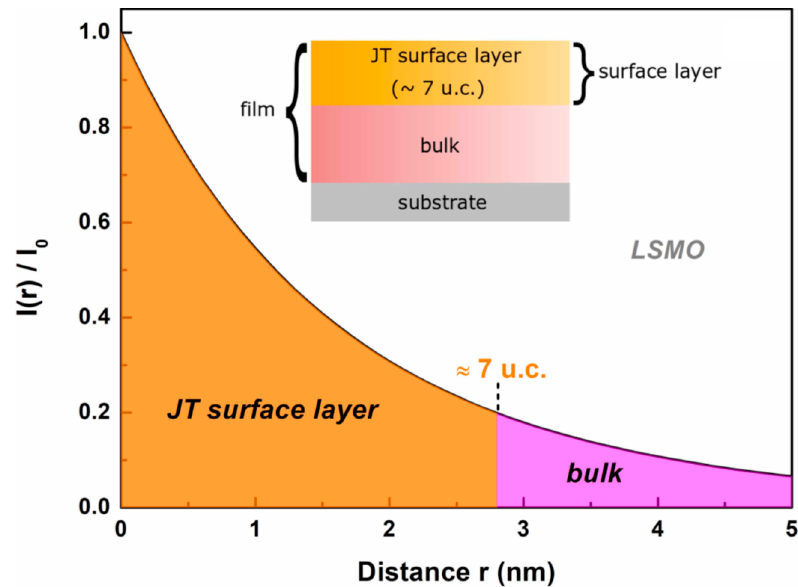
Figure 9. The distance dependence of plasmonic enhancement and the estimated thickness of the surface layer in LSMO. The inset shows the proposed model of the surface layer. [32]. “Licensed under the Creative Commons Attribution 4.0 International License, http://creativecommons.org/licenses/by/4.0/”.